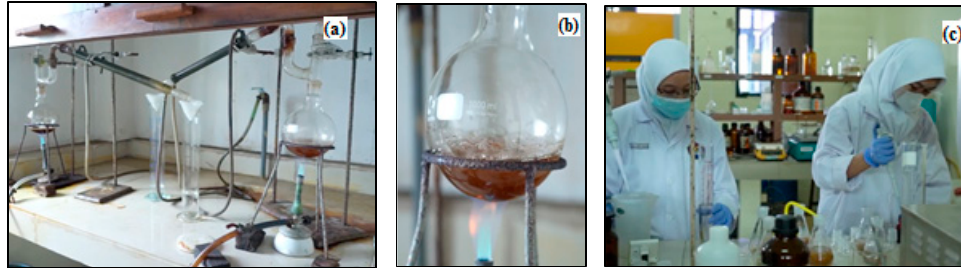
Figure 7. ( a ). SNI-Pulp Rayon; ( b ). Round bottom flask; ( c ). EFB pulp dissolving test process.